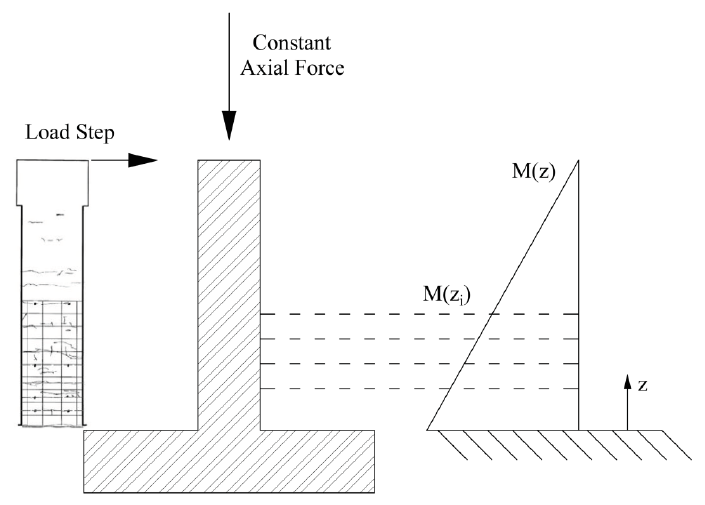
Figure 10. Bending Moment Profile M(z